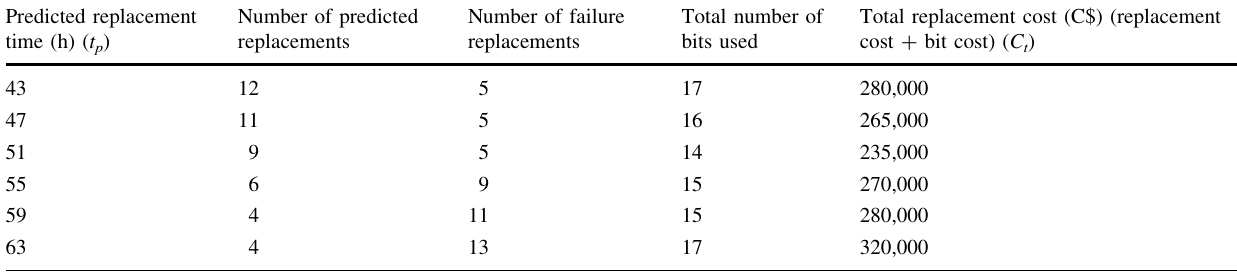
Table 3 Predicted drill bit replacement times and costs based on MC Predicted replacement time (h) ( t p